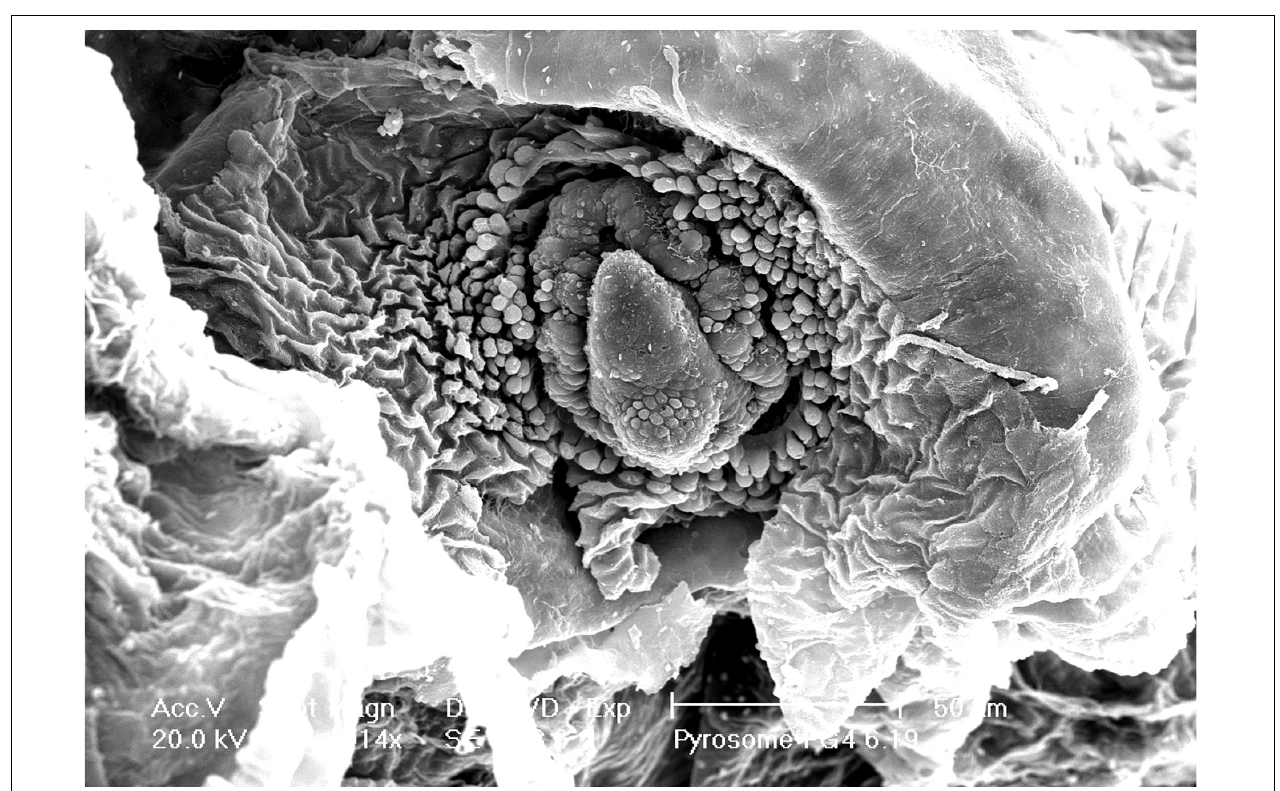
FIGURE 4 | Intact light organ ( ∼ 30 µ m diameter) semi encased in the tunic. Intracellular microbial cells were not discernable due to the intact light organ. Scale bar is set at 50 µ